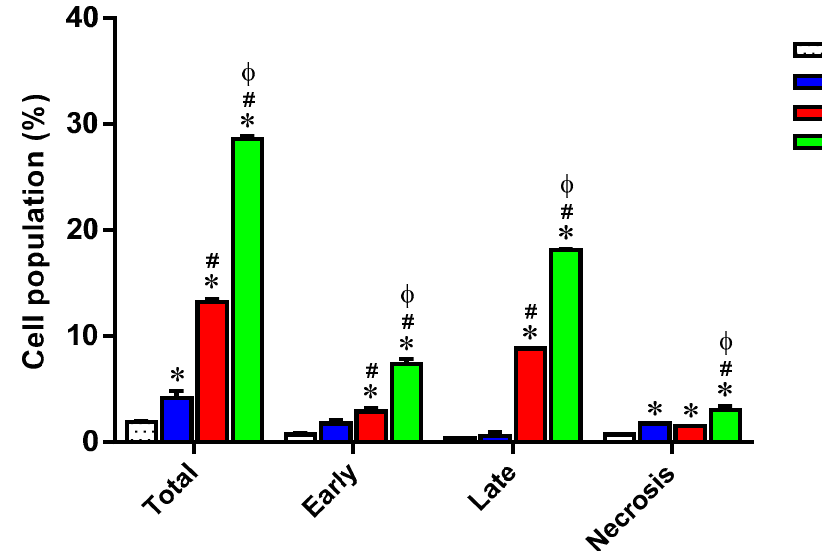
Figure 6. Impact of Blank EMLs, FBX-R, or optimized FBX-EMLs treatments on the percentage of